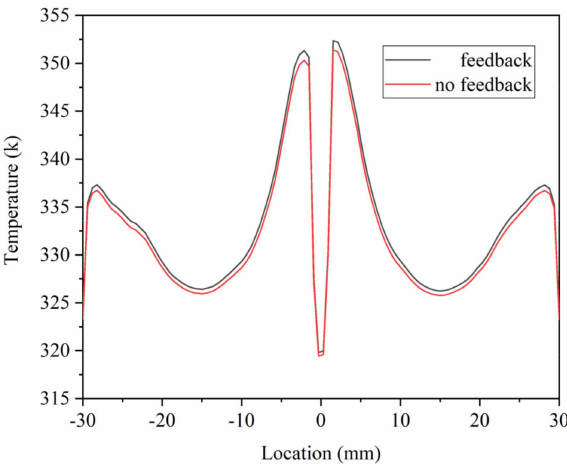
Figure 21. Comparison of temperature changes on metal plates under unidirectional and bidirectional magneto − thermal